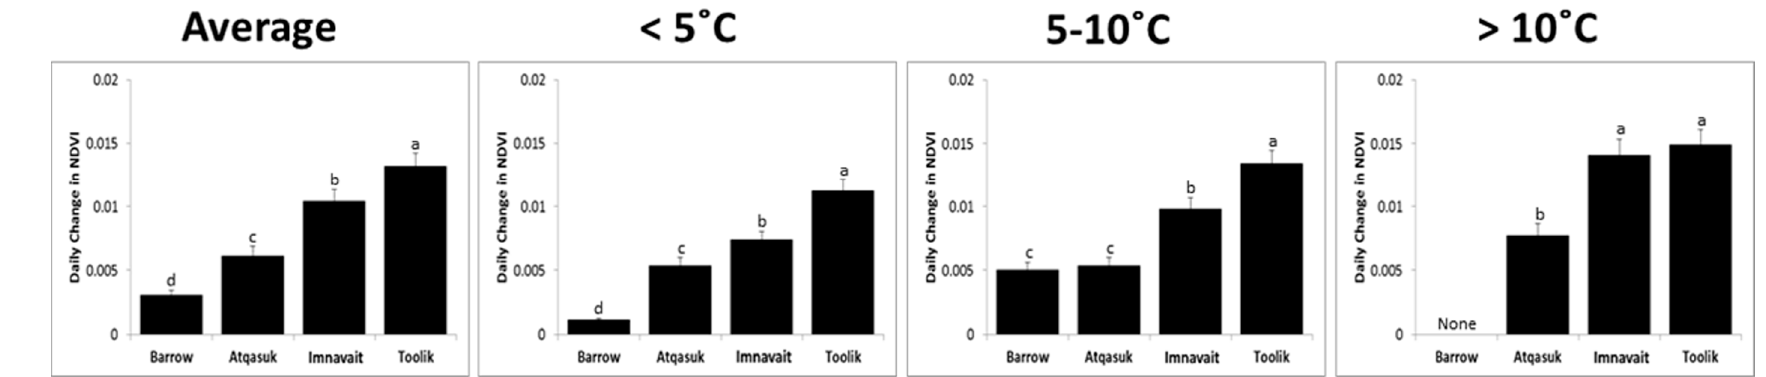
Figure 4. Daily changes in NDVI (as calculated from the three-day lagged NDVI difference) for the four MISP full transects as June averages and following days of temperatures <5 °C, 5–10 °C, and >10 °C. The letters denote statistical differences derived from repeated measures analysis of variance with Tukey’s post hoc analysis.